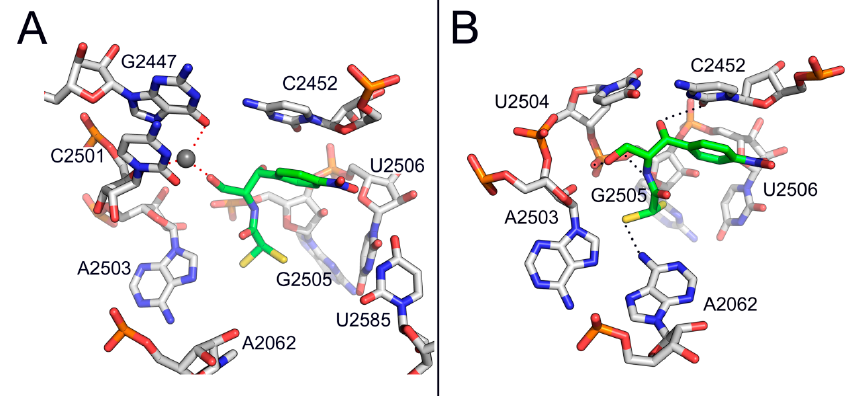
Figure 4. Binding positions of CAM (in green) in the ( A ) Thermus thermophilus and ( B ) Escherichia coli ribosome, as detected by crystallography (PDB ID code 4V7W and 3OFC, respectively).